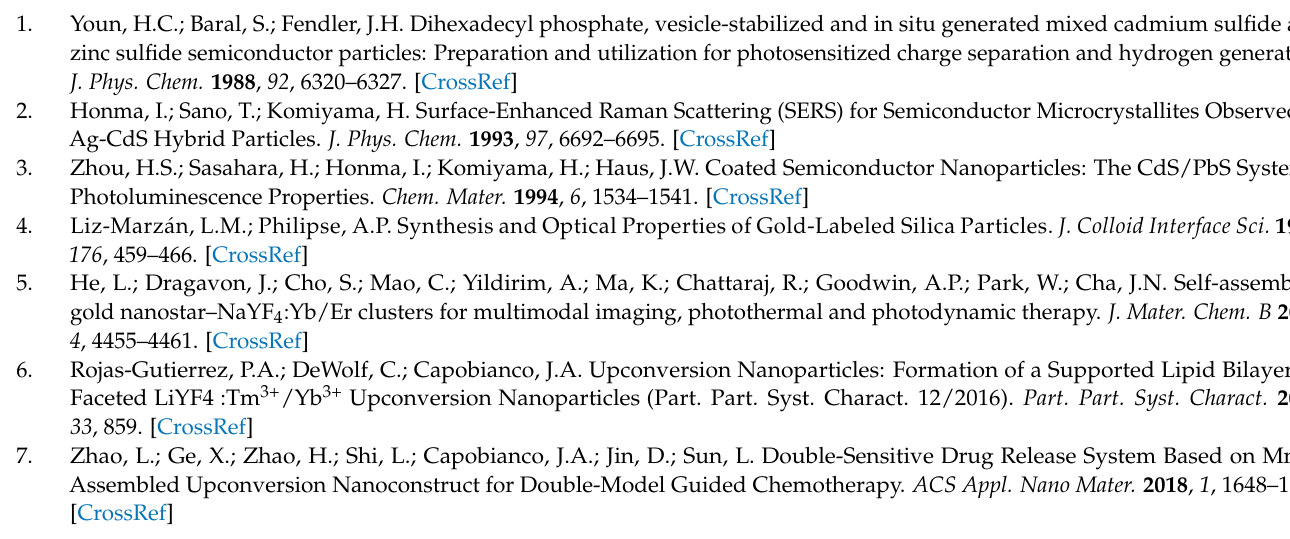
group Fm - 3m . Figure. S2 TEM image sections of SiO 2 @AuNS( R = 128.0) demonstrating the high ratio of coated SiO 2 nanoparticles with 4,000 times magnification (a) and 10,000 times magnification (b). Figure. S3 TEM images of SiO 2 @AuNS( R = 64.0, light blue) (a), and SiO 2 @AuNS( R = 128.0, dark blue) (b) stored fo r seven month in ethanol and corresponding extinction spectra of the nanostructures (c). Solid lines show the initial spectra while dashed lines mark the spectra of the nanostructures recorded afte r seven month. Figure. S4–1 Extinction spectrum and TEM image of the SiO 2 @AuNS fo r R = 0.6 (500.0 µ L of the seed solution) with a gold nanostructure size of 11.3 ± 1.9 nm. Figure. S4–2 Extinction spectrum and TEM image of the SiO 2 @AuNS fo r R = 3.2 (100.0 µ L of the seed solution) with a gold nanostructure size of 20.4 ± 4.6 nm. Figure. S4–3 Extinction spectrum and TEM image of the SiO 2 @AuNS for R = 12.8 (25.0 µ L of the seed solution) with a gold nanostructure size of 46.0 ± 12.8 nm. Figure. S5–1 Histograms of the core and the total diamete r of SiO 2 @AuNS (C) with a mass ratio of 64.0 (5.0 µ L of the seed solution) determined by TEM. Figure. S5–2 Histograms of the core and the total diamete r of SiO 2 @AuNS (D) with a mass ratio of 128.0 (2.5 µ L of the seed solution determined by TEM). Figure. S6 Normalized